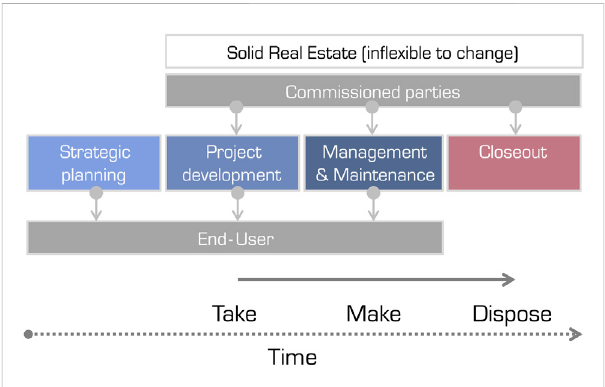
FIGURE 4 Diagram of the “ Solid Real Estate ” created by development